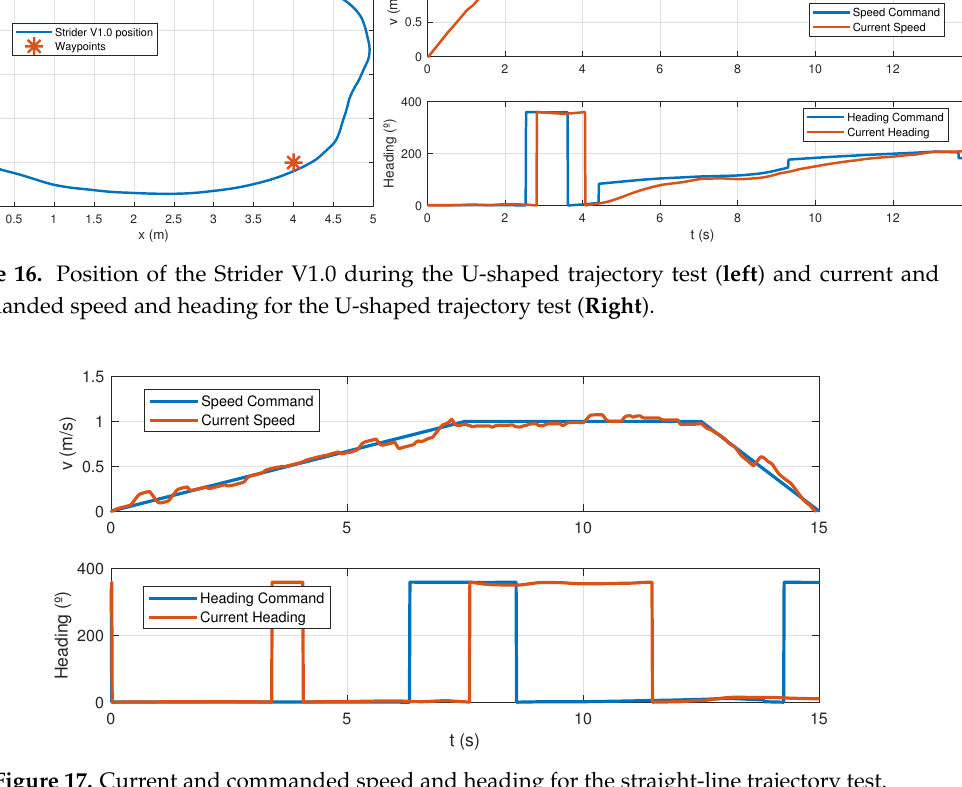
Figure 17. Current and commanded speed and heading for the straight-line trajectory